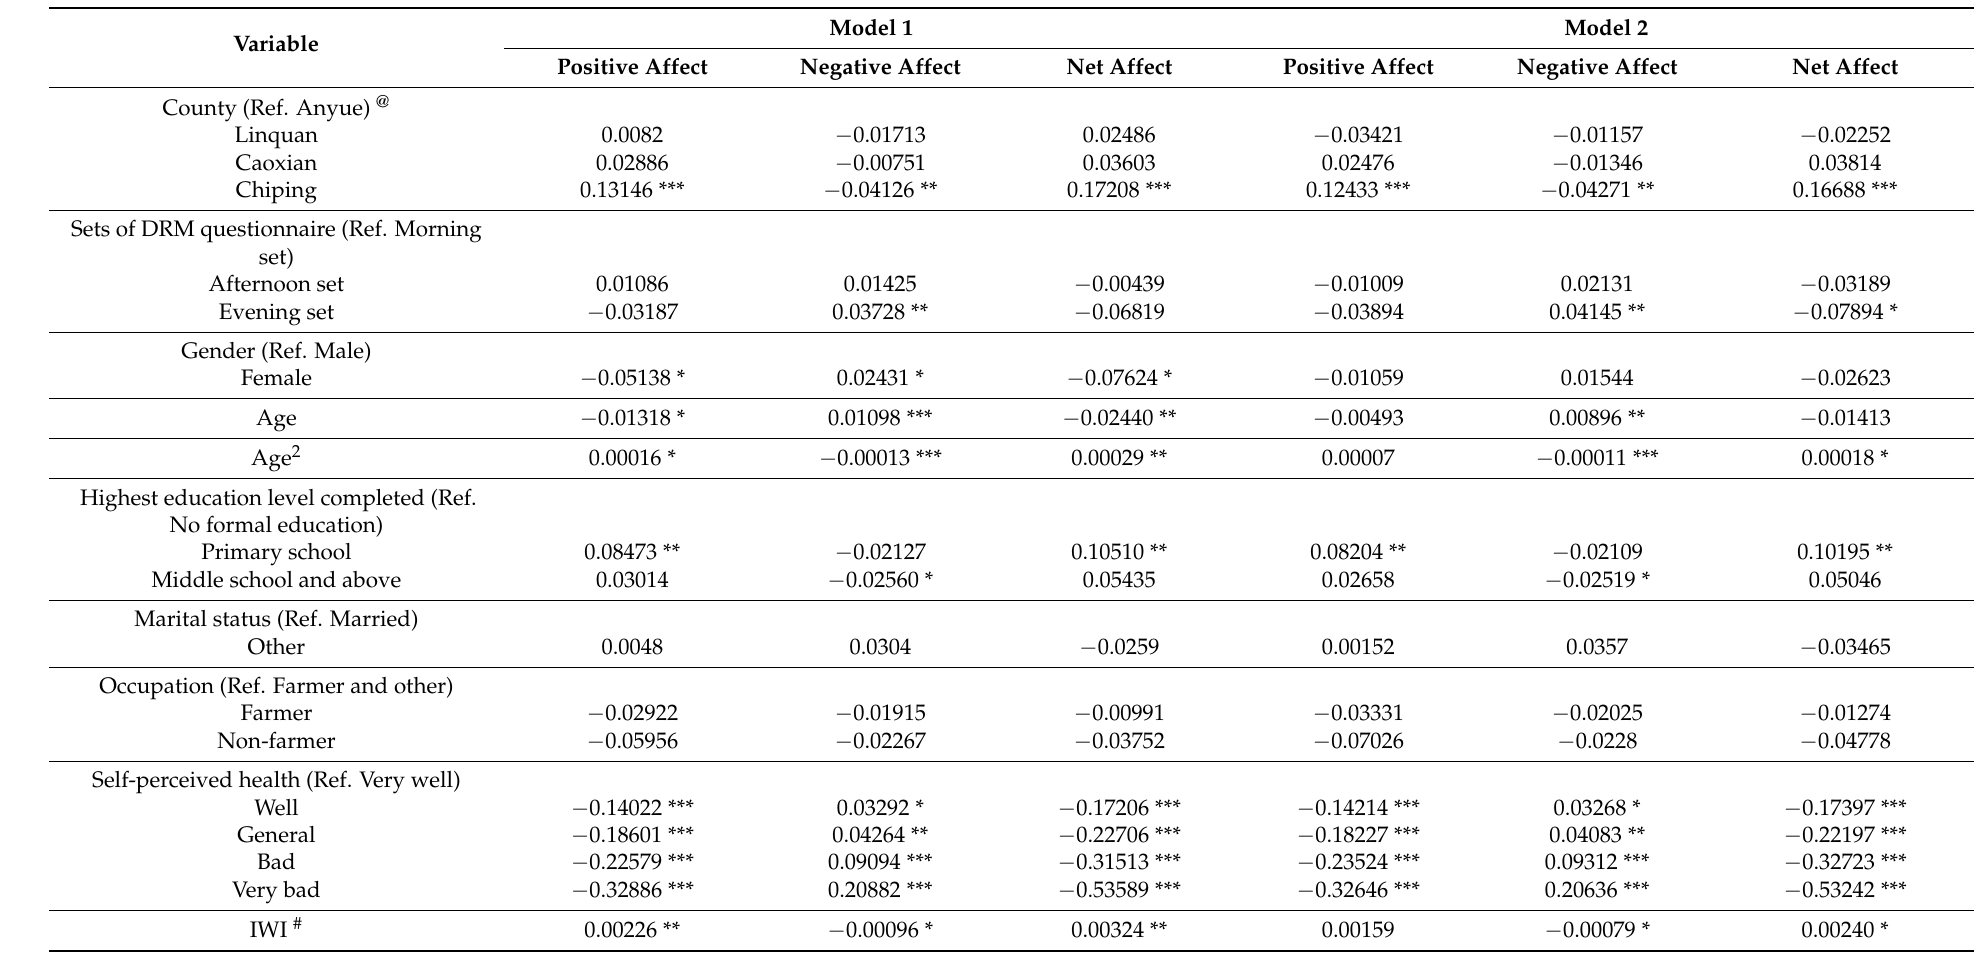
Table 4. Results of multilevel analyses of time of day (ToD) and SWB